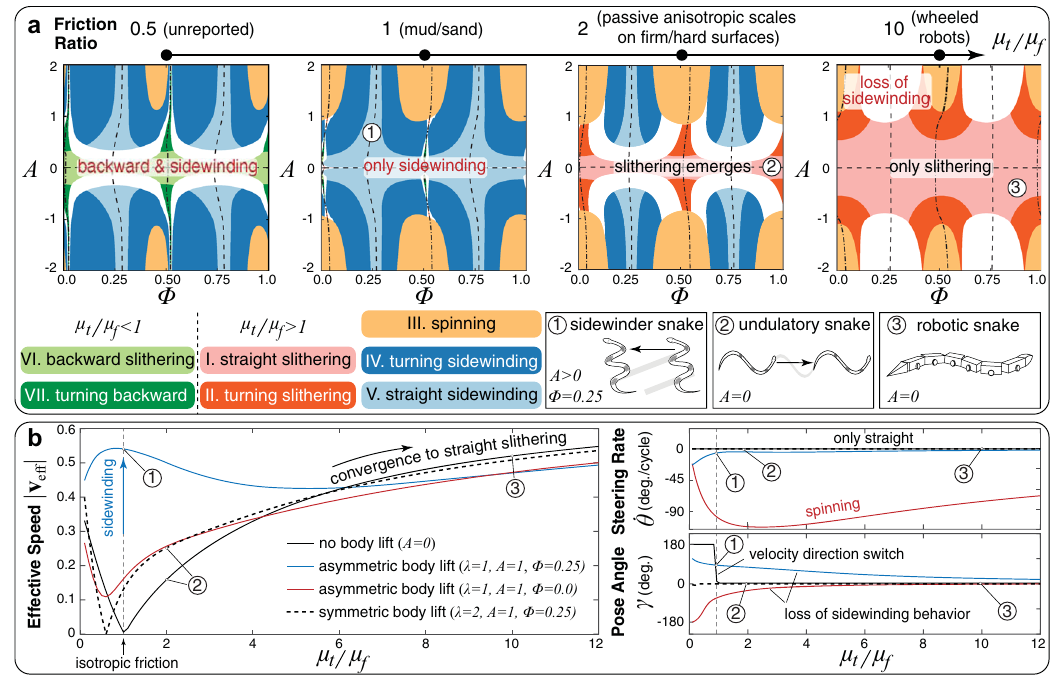
Fig. 3 Emergence of locomotory behaviors in context with the environment – in fl uence of friction ratio. a Phase space maps for different friction ratios μ μ t / f (full exploration in SI). Numbered labels indicate the location in terms of friction ratio, lifting amplitude, and phase offset of typical locomotion behaviors: (1) a snake sidewinding in a sandy desert or a tidal mud fl at 23 , (2) an undulating snake with no body lift based on measurements from 13 , and (3) a wheeled robotic snake where the wheels can be viewed as inducing strong friction anisotropy. Note that for μ t / μ f = 1, straight sidewinding does not occur for A = 0 as the snake is unable to produce directional motion when there is no body lift. b Effective speed, steering rate, and pose angle of four different lifting strategies over a range of friction ratios. Different body lifting strategies lead to large differences in all three quantities at low friction anisotropy ratios, while there is a general convergence of behaviors to traveling forward in a straight trajectory as friction anisotropy increases. For isotropic friction, the no lifting case of A = 0 corresponding to planar slithering has ∣ v eff ∣ = 0, while asymmetric lifting with A = 1 and Φ = 0.25, corresponding to sidewinding 26, 27 , exhibits high ∣ v eff ∣